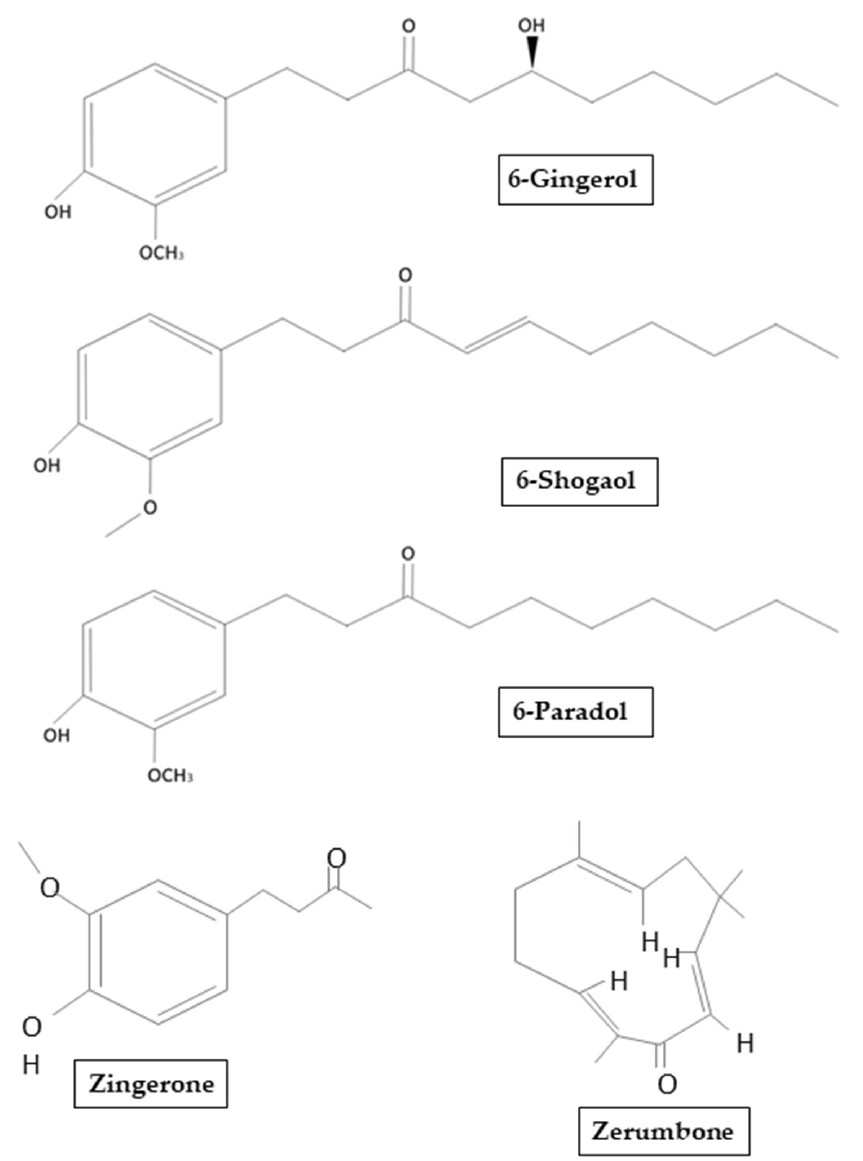
Figure 2. Chemical structure of main ginger derivates that will be mentioned in our review. Among the biologically active compounds of terpenes, gingerols are the most abun- dant [13], with 6-gingerols containing a high amount [14]: analytical analyses determined that the amount of 6-gingerols was between 57.67 and 62.64 mg/g of